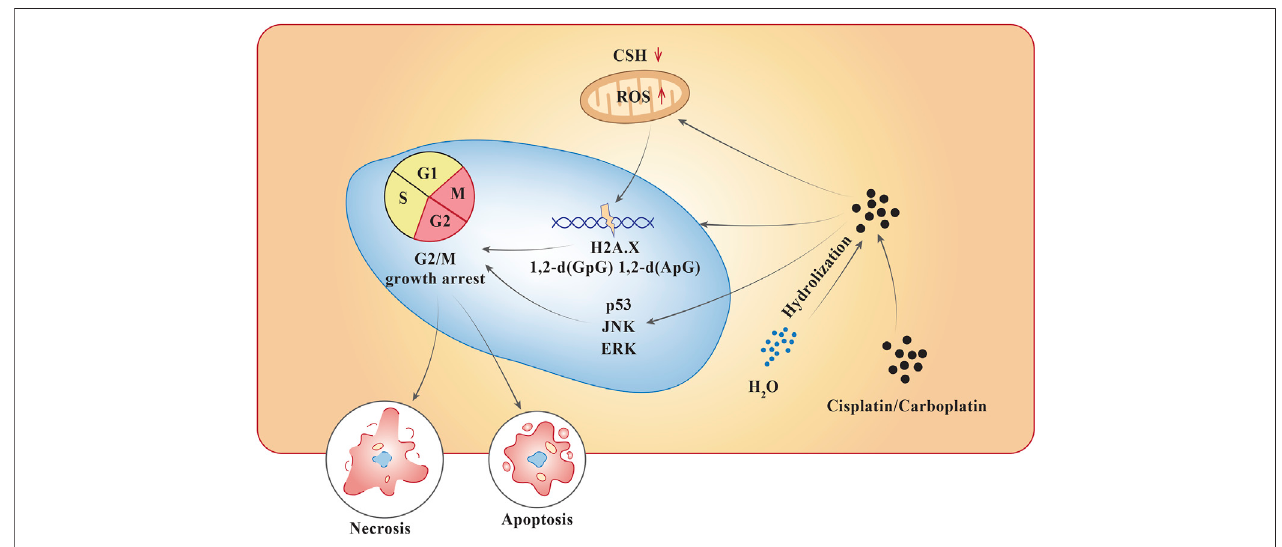
FIGURE 2 | Mechanism of action of platins in neoplastic